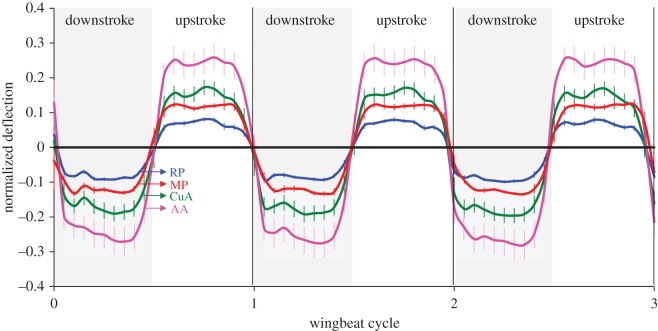
Wing deflections. Mean (error bars are ± 1 s.e.) deflections at the trailing edge during free flight in three consecutive flapping cycles (n = 14 beetles). Deflections are normalized by wing length and time is normalized by the flapping cycle of each beetle. Positive and negative values signify deflection towards the anatomical dorsal and ventral sides of the wing, respectively. Black denotes the relative null deflection of landmarks on the leading edge; magenta, green, red and blue denote deflections of landmarks on the trailing edge (AA, CuA, MP and RP, respectively; figure 1a).